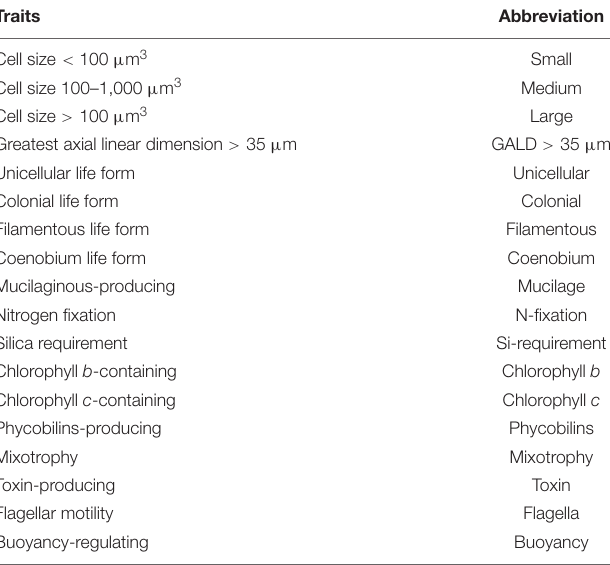
TABLE 2 | Phytoplankton functional traits used in this